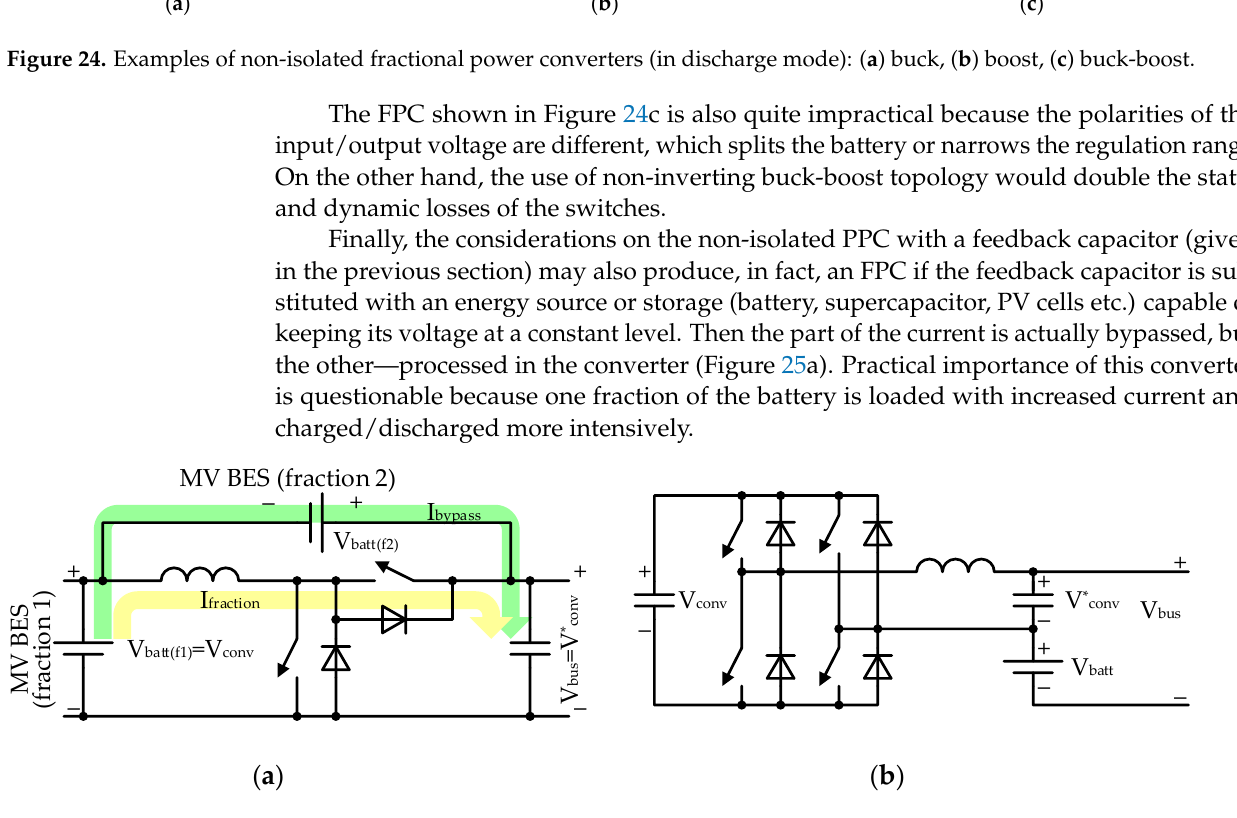
Figure 24. Examples of non-isolated fractional power converters (in discharge mode): ( a ) buck, ( b ) boost, ( c ) buck-boost.